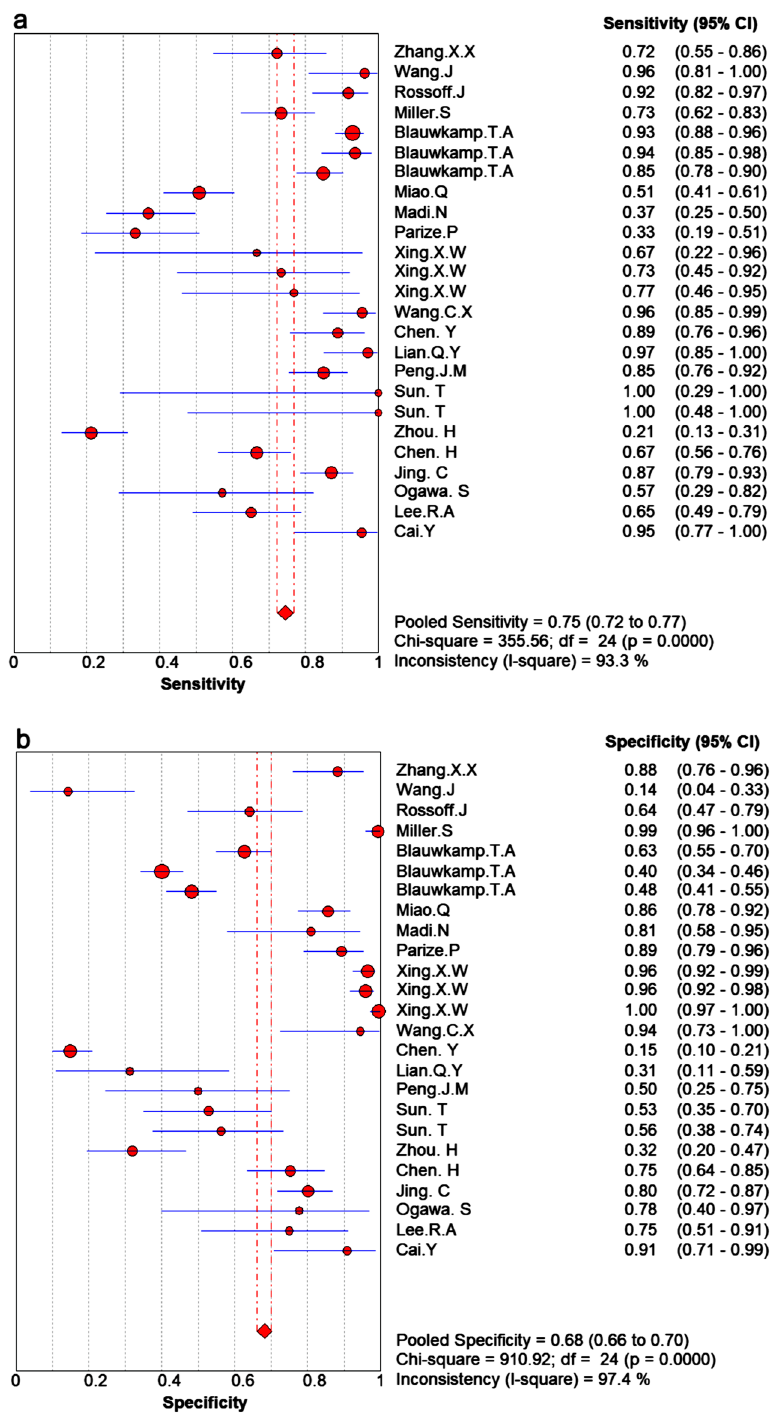
Figure 3. Forest plot of estimates results: ( a ) Sensitivity; ( b )